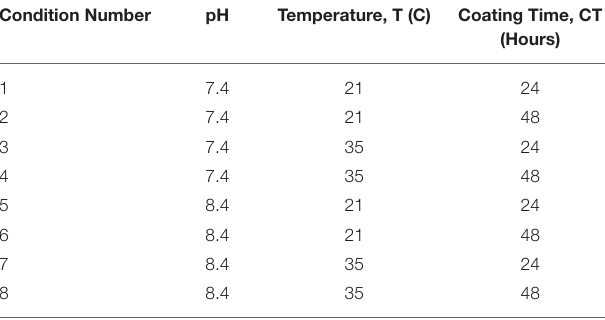
TABLE 1 | pDA coating